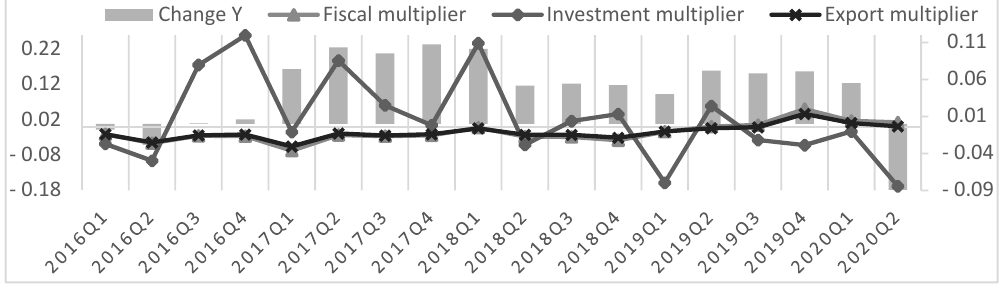
Figure 14. Changes in autonomous expenditure multipliers and GDP—Poland, own work, source: Eurostat.